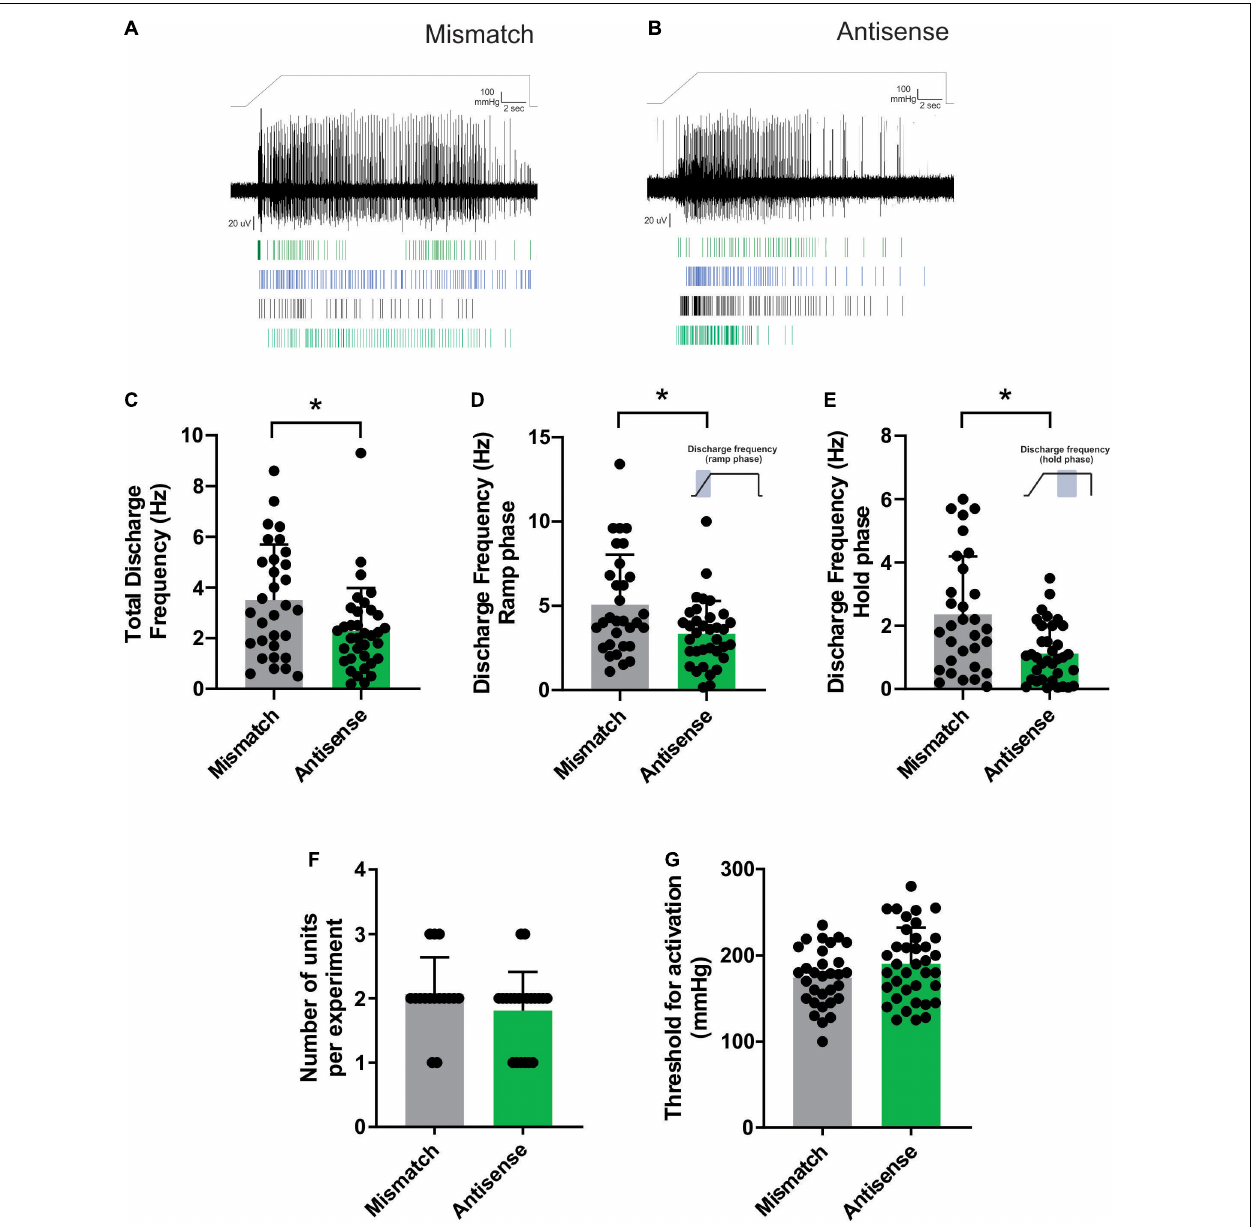
FIGURE 2 | Piezo2 knockdown alters the response of A δ bone afferent neurons to noxious mechanical stimulation. (A,B) Examples of whole-nerve recordings, and rasters of single unit activity, from Piezo2 mismatch (A) and antisense (B) ODN treated animals. (C) There was a significantly reduced total discharge frequency in A δ bone afferent neurons recorded from Piezo2 antisense treated animals compared to mismatch control animals [mixed model, F (3.278), DFn (2), Dfd (43), *Dunnett’s P < 0.05; n = 23 naïve/31 mismatch/35 antisense, N = 10 naïve/15 mismatch/21 antisense]. The reduction in discharge frequency was observed during both the (D) ramp [F (3.641), DFn (2), Dfd (43), Dunnett’s P < 0.05; n = 23 naïve/31 mismatch/35 antisense, N = 10 naïve/15 mismatch/21 antisense] and the (E) hold phase of the pressure stimulus [F (5.757), DFn (2), Dfd (43), Dunnett’s P < 0.05; n = 23 naïve/31 mismatch/35 antisense, N = 10 naïve/15 mismatch/21 antisense]. (F) There was no difference in the number of A δ bone afferent neurons isolated per experiment in recordings made from Piezo2 knockdown compared to mismatch control animals ( P > 0.05, unpaired t -test, n = 33 mismatch/38 antisense, N = 16 mismatch/21 antisense). (G) There was no difference in the threshold for mechanical activation of A δ bone afferent neurons in recordings made from Piezo2 knockdown compared to mismatch control animals [mixed model, F (6.139), DFn (2), Dfd (45), Dunnett’s P > 0.05; n = 23 naïve/31 mismatch/35 antisense, N = 10 naïve/15 mismatch/21 antisense].